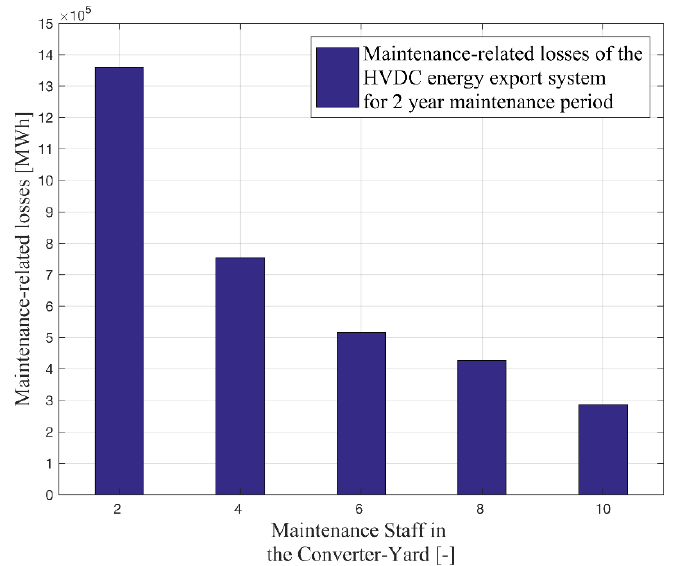
Figure 11. Maintenance-related losses for the total operation time of the HVDC system over different number of maintenance staff in the converter yard.